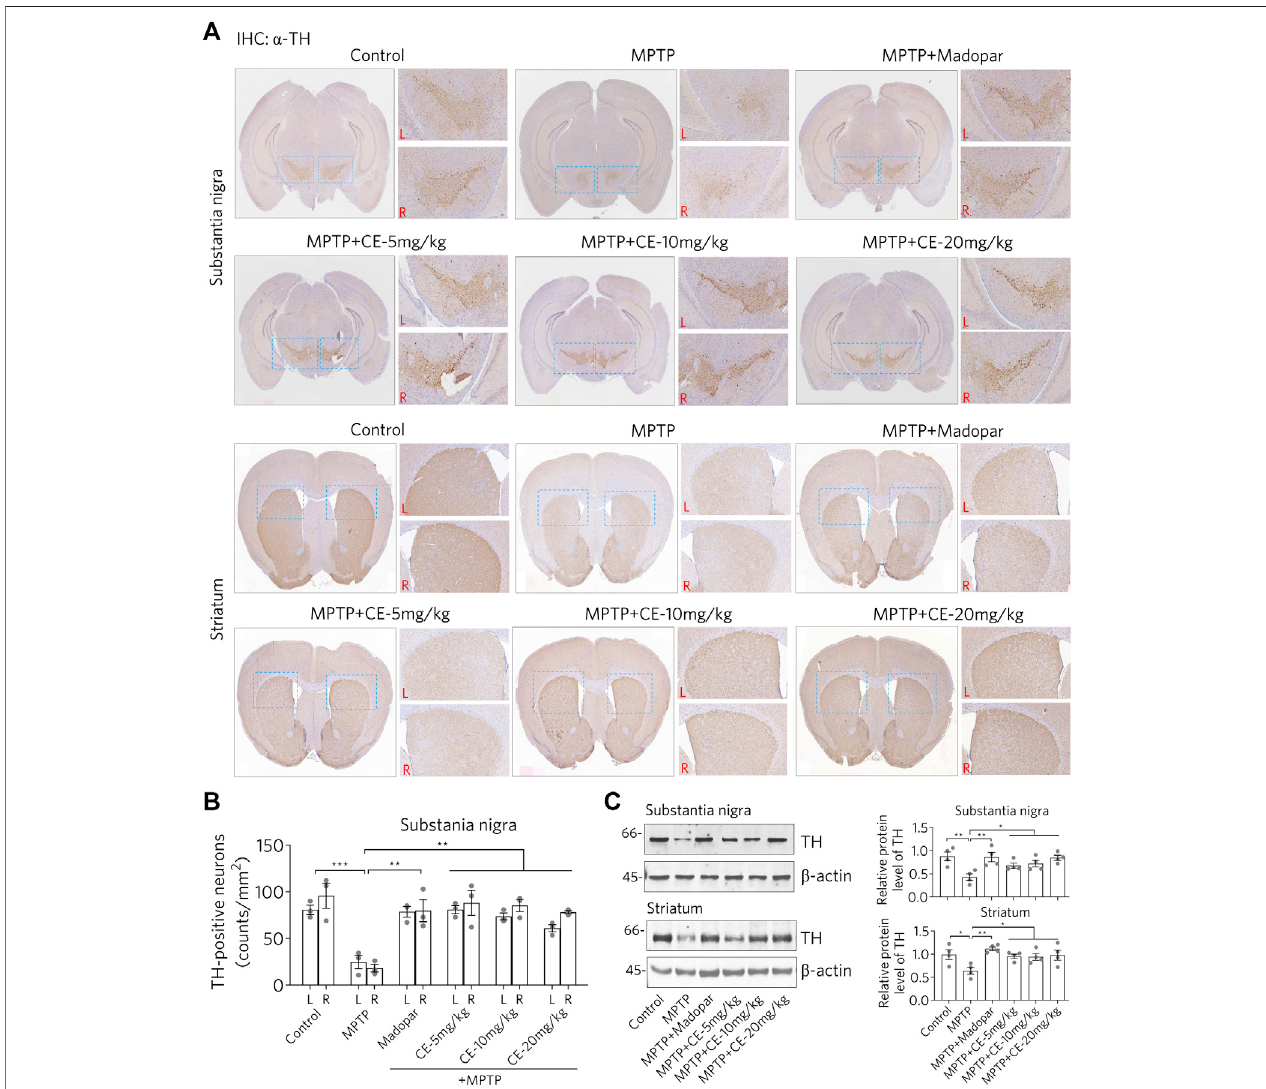
FIGURE 2 | CE attenuates MPTP-induced loss of dopaminergic neurons in substantia nigra and striatum. (A) IHC analysis of nigrostriatal TH-positive cells. Scale bar,1 mm.L,left;R,right.Statisticaldifferencesbetweengroupswerecalculatedbyone-wayANOVAandposthocDunnett ’ stest, n =3. (B) CountsofTH-positivecells. (C) Western blotting of TH protein. Relative protein levels were measured based on the density of blotted bands and normalized to β -actin. One-way ANOVA and post hoc Dunnett ’ s test were performed to verify the signi fi cance of differences between groups, n = 4.